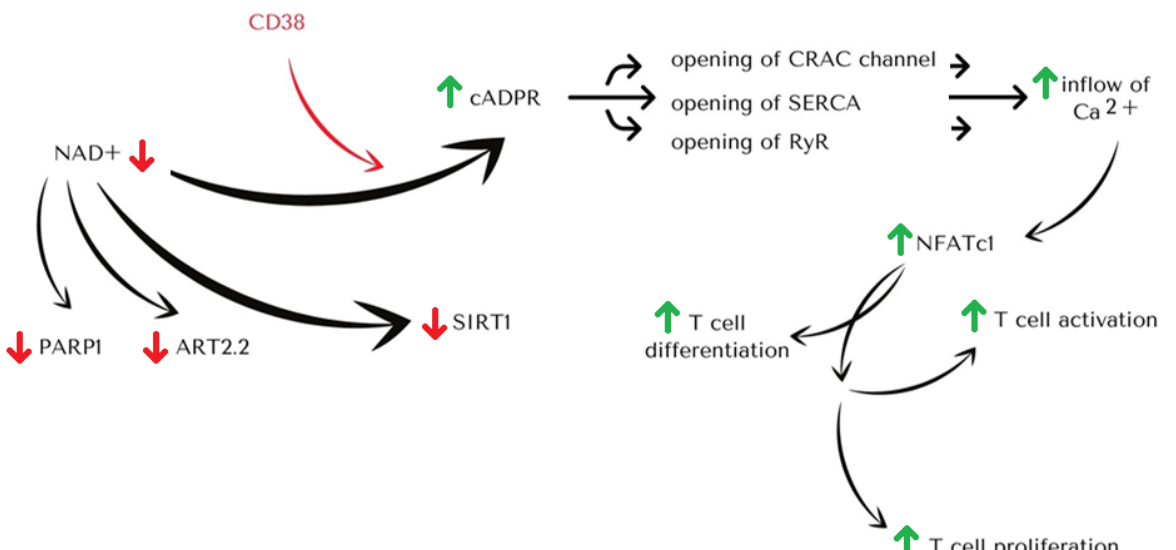
Figure 1. Schematic representation of the role of CD38 in NAD+ metabolism. CD38 depletes NAD+ cellular level, generating cyclic ADP-ribose (cADPR). The process leads to the inflow of Ca 2+ stimulates T cell activation and proliferation. Depletion of NAD+ level affects the activity of Sirt1, ART2.2, and PARP1, which are NAD+ consuming enzymes that play significant roles in T cell fate determination.